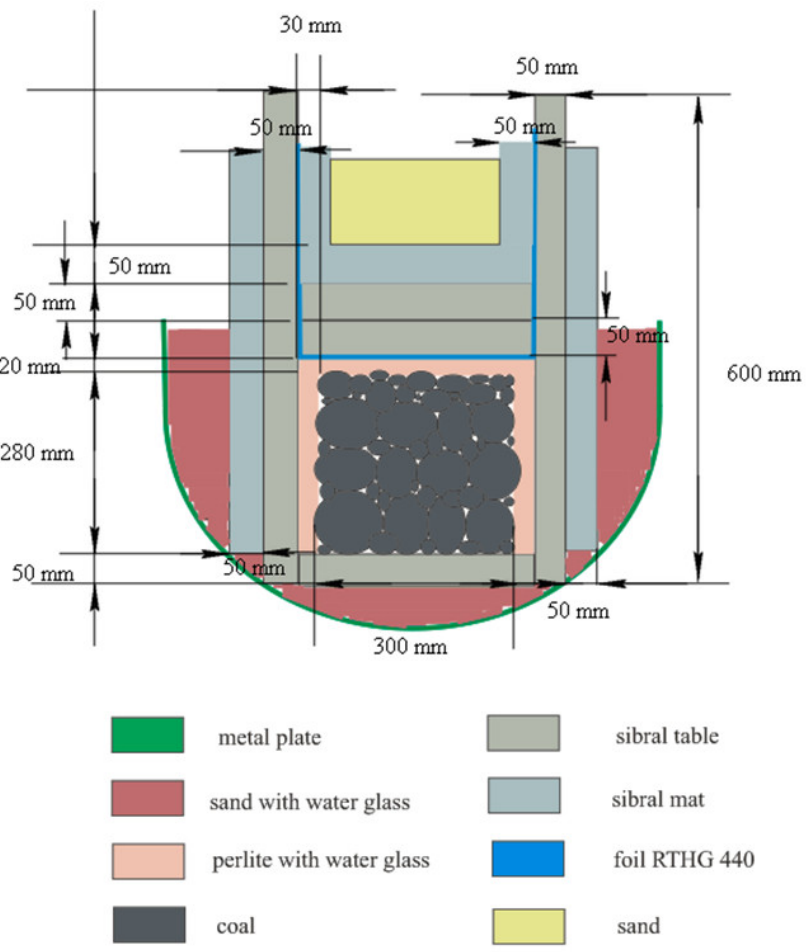
Figure 3. Figure 3. The scheme of the cross-section for the physical model of the coal seam for the second experiment.